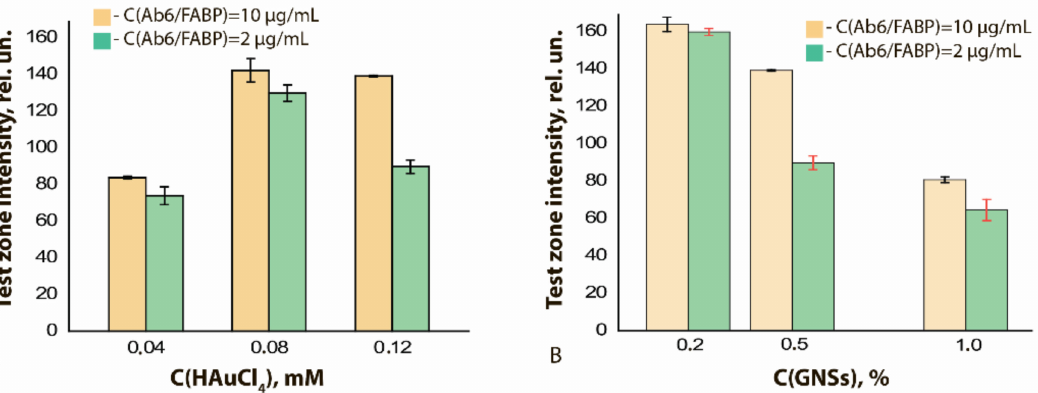
Figure 9. Dependences of the color intensity of the TZ for LFIA test strips for FABP after testing samples containing 300 ng/mL of FABP: ( A ) on the concentration of HAuCl 4 in the reaction mixture at a constant concentration of nuclei (0.5% v / v ); ( B ) on the concentration of nuclei at a constant concentration of HAuCl 4 (0.12